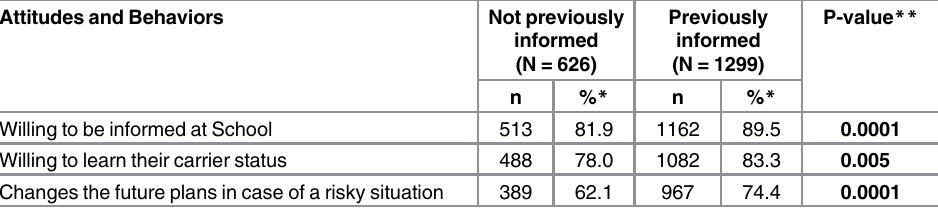
Table 2. Attitude and behavioral pattern of students about haemoglobinopathies according to their status of being previously informed. Attitudes and Behaviors